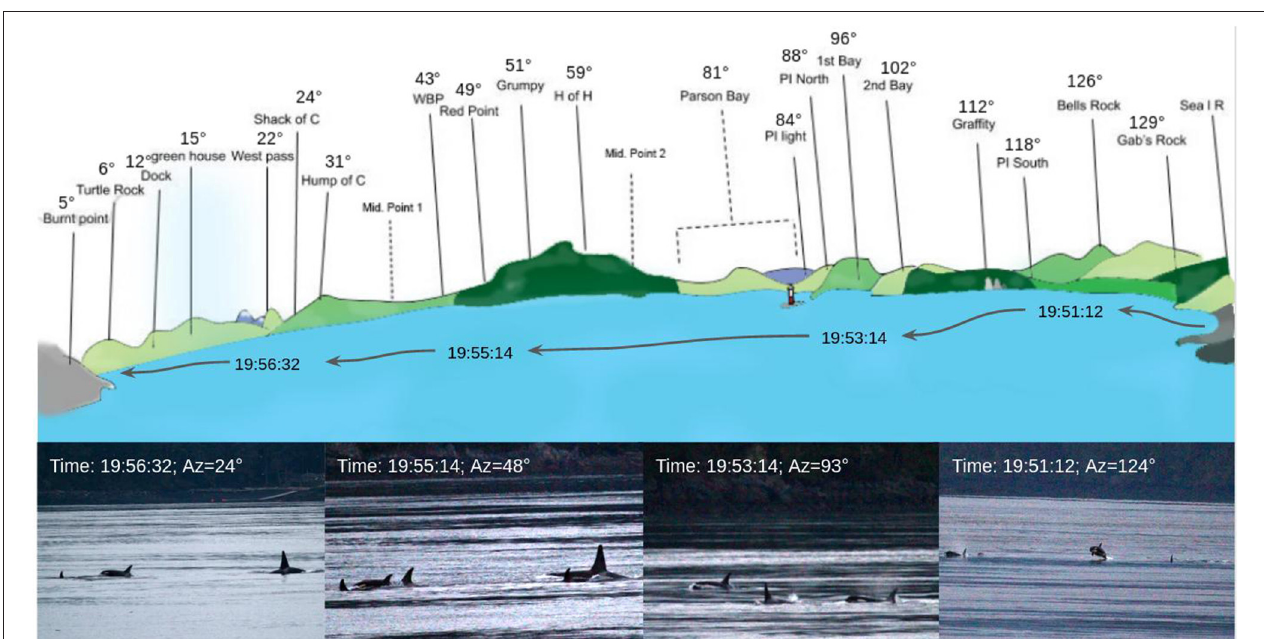
FIGURE 7 | Graph of the passage of the 30th of August. Top: representation of the view of Blackney Pass from Orcalab with the visual position of the group. Bottom: pictures taken from Orcalab deck.